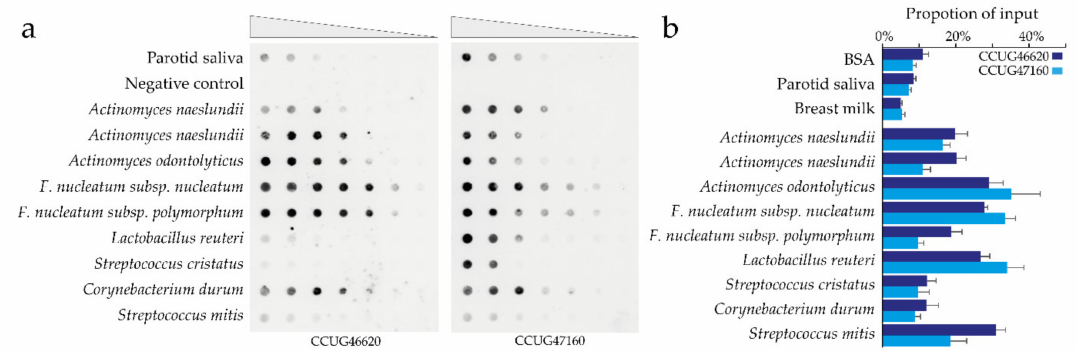
Figure 4. Surface-based C. matruchotii coadhesion partners. ( a ) Serial dilution of potential coadhesion partners for C. matruchotii (50 µ L of OD 600 from 0.5 to 0.004) were evaluated for binding of FITC-labeled C. matruchotii . The signal represents the binding of labeled C. matruchotii to filters coated with potential partner bacteria. ( b ) Proportion 35 S-labeled C. matruchotii binding to saliva-coated or saliva-partner bacteria-coated hydroxyapatite beads. The bars represent mean and SD of three independent